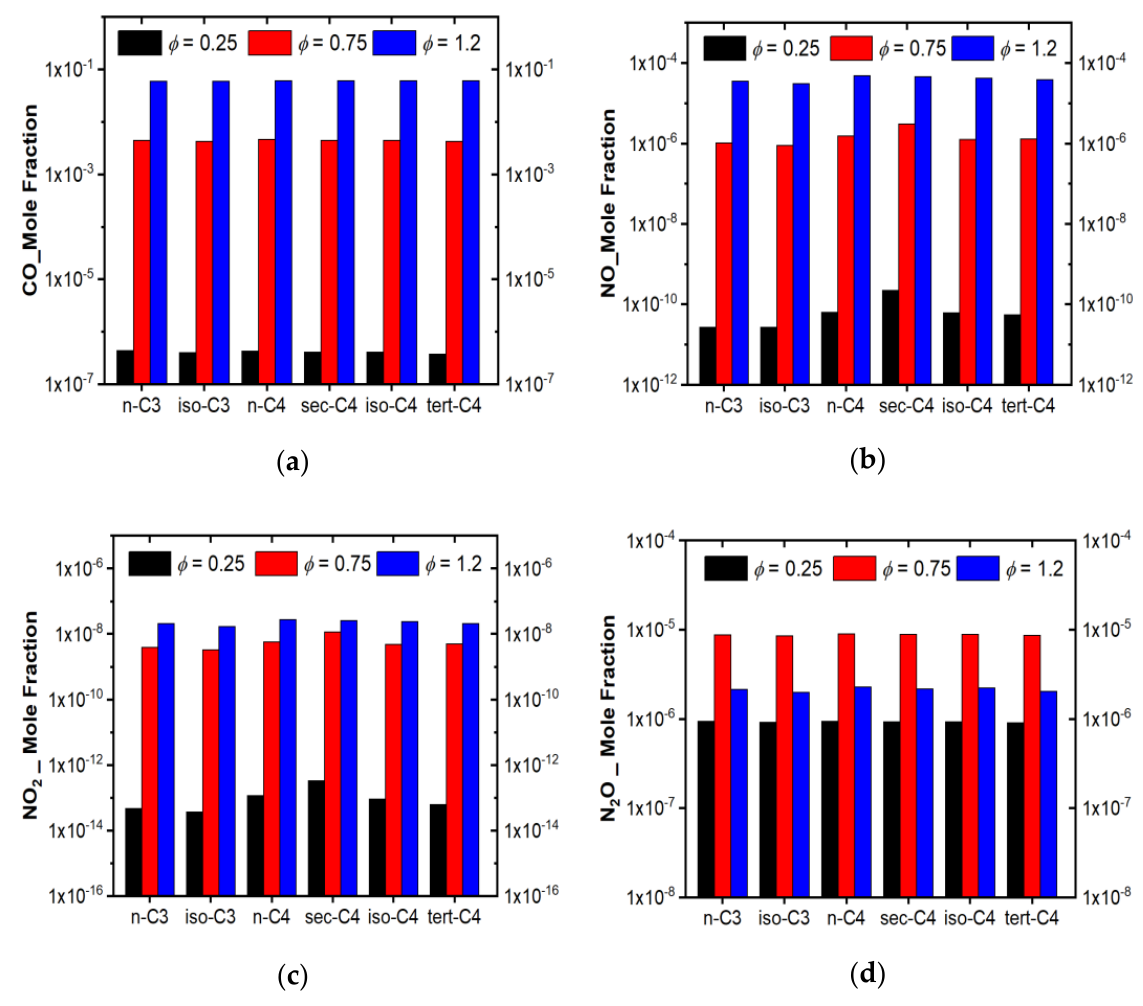
Figure 14. Model prediction for the final mole fraction of ( a ) CO, ( b ) NO, ( c ) NO 2 , and ( d ) N 2 O emissions from the oxidation of propanol and butanol isomers during the ignition process at 860 K and 36 atm for the unburned fuel/air-mixture.